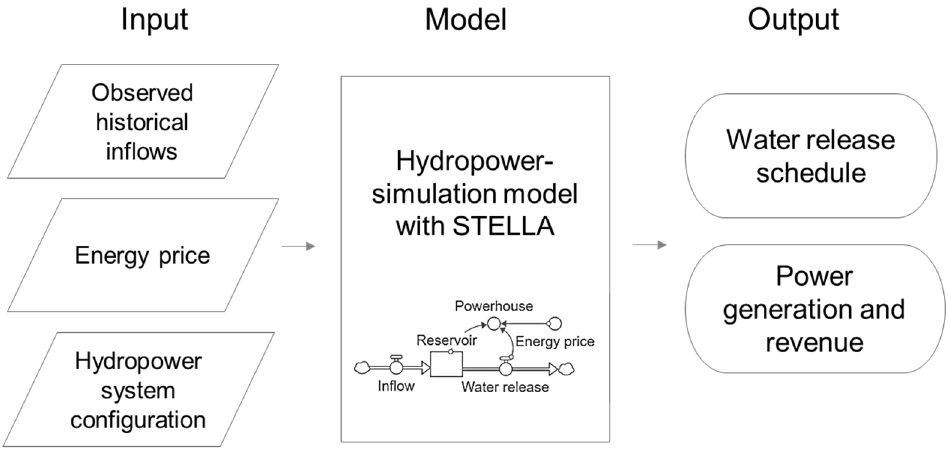
Figure 4. Flowchart of the hydropower simulation model.